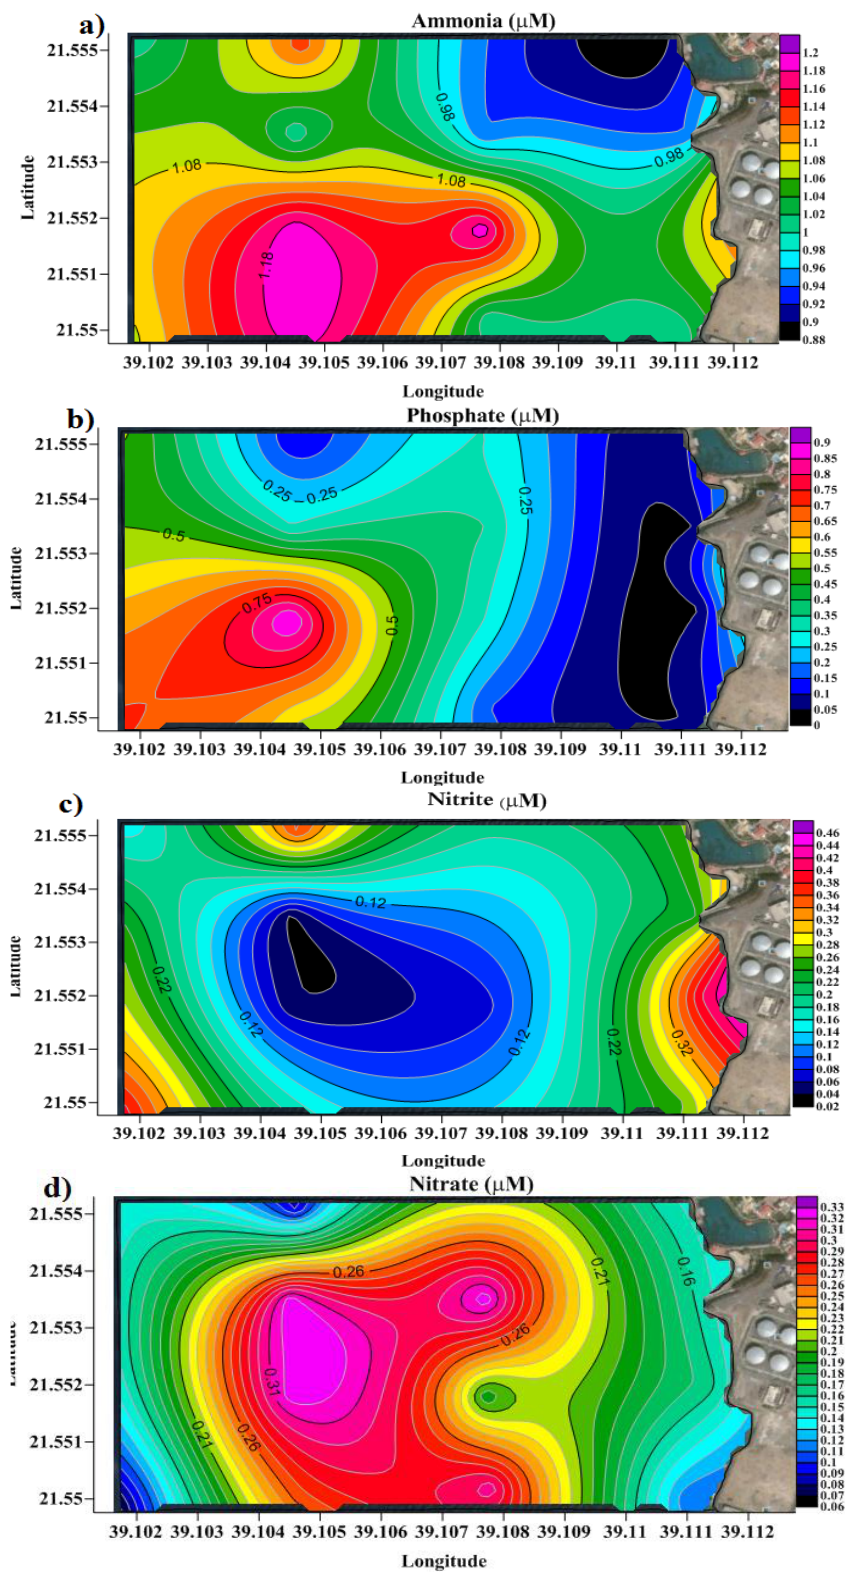
Figure 5: Surface distribution pattern of a) ammonia, b) phosphate, c) nitrite, and d) nitrate.